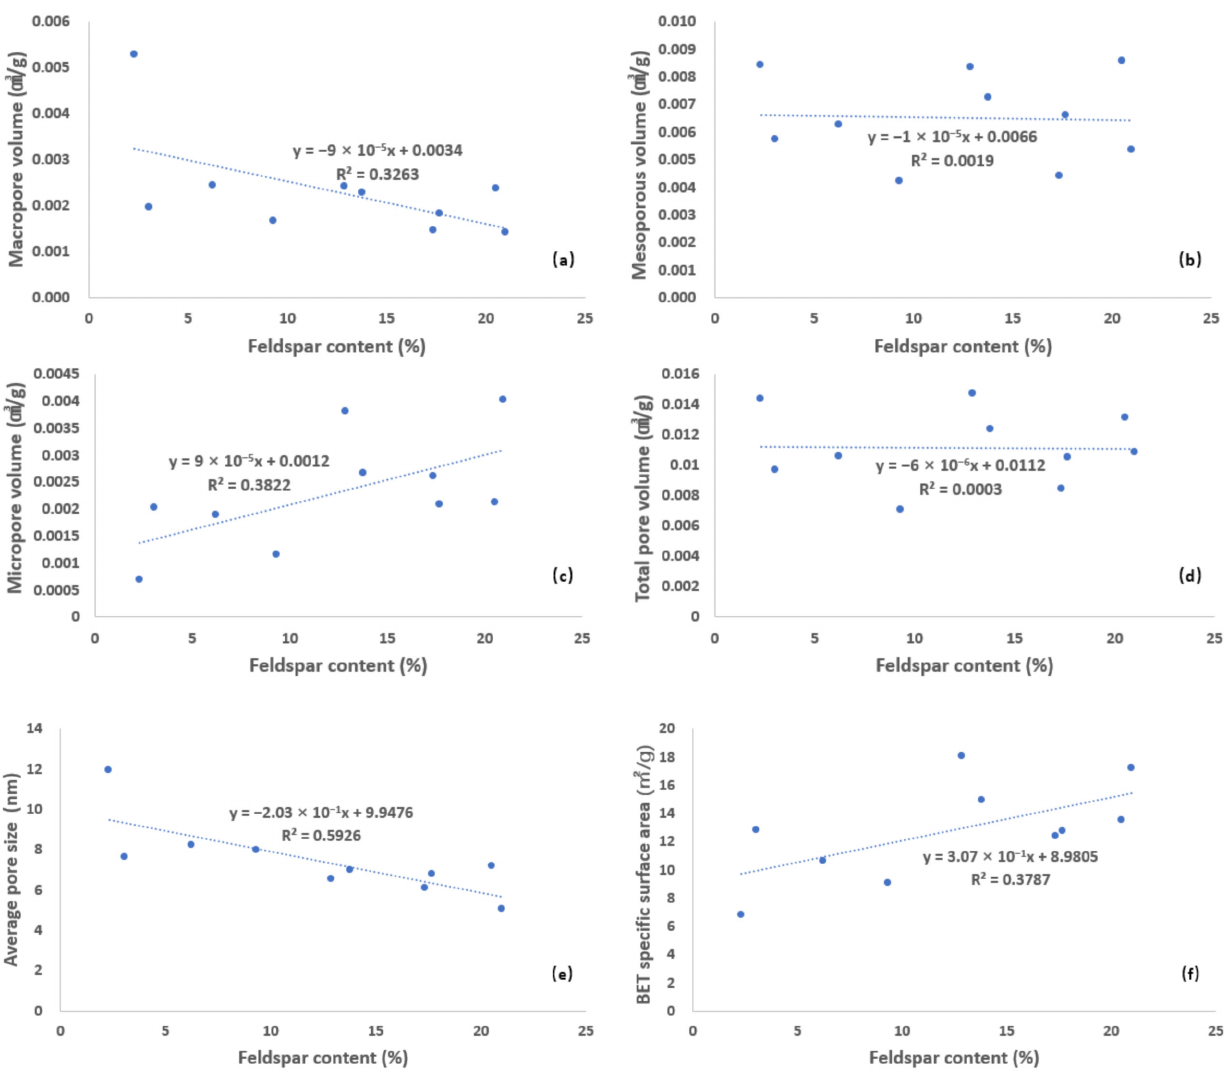
Figure 11. Relationship between microscopic pores and feldspar content of the lower Cambrian the Niutitang formation black shale in Wenshuicun section, Guizhou province; ( a ) the cross plot of macro-pore volume and feldspar content; ( b ) the cross plot of mesoporous volume and feldspar content; ( c ) the cross plot of micropore volume and feldspar content; ( d ) the cross plot of total pore volume and feldspar content; ( e ) the cross plot of BET specific surface area and feldspar content; ( f ) the cross plot of average pore size and feldspar